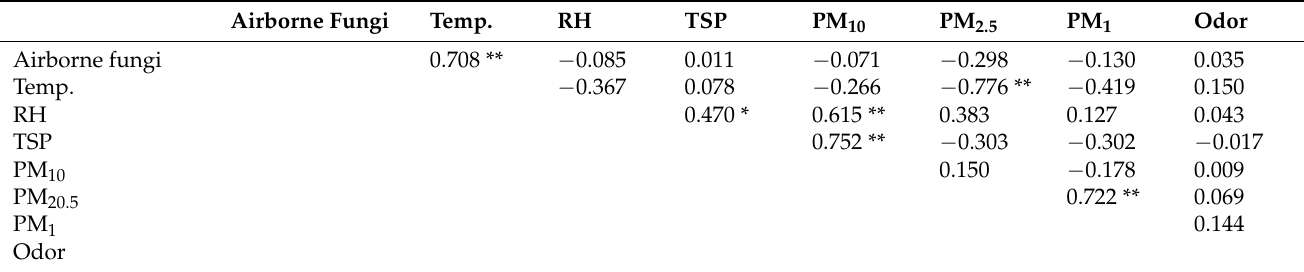
Table 2. Correlation relationship between airborne fungi and indoor environmental